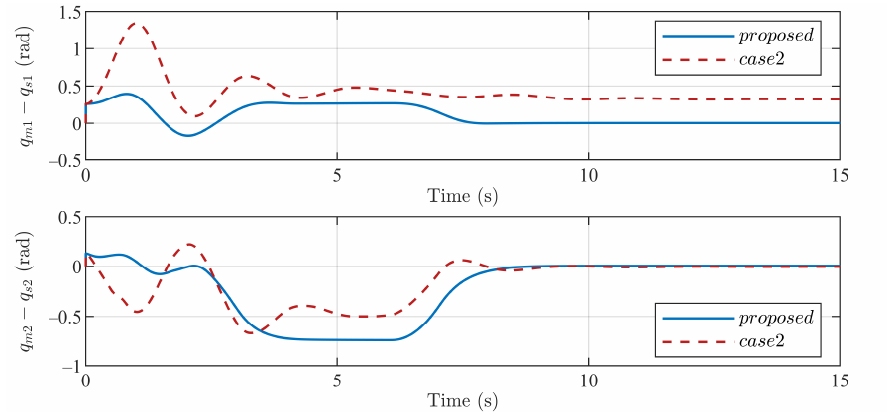
Figure 15. Comparisons of joint tracking errors with the proposed method and Case 2.